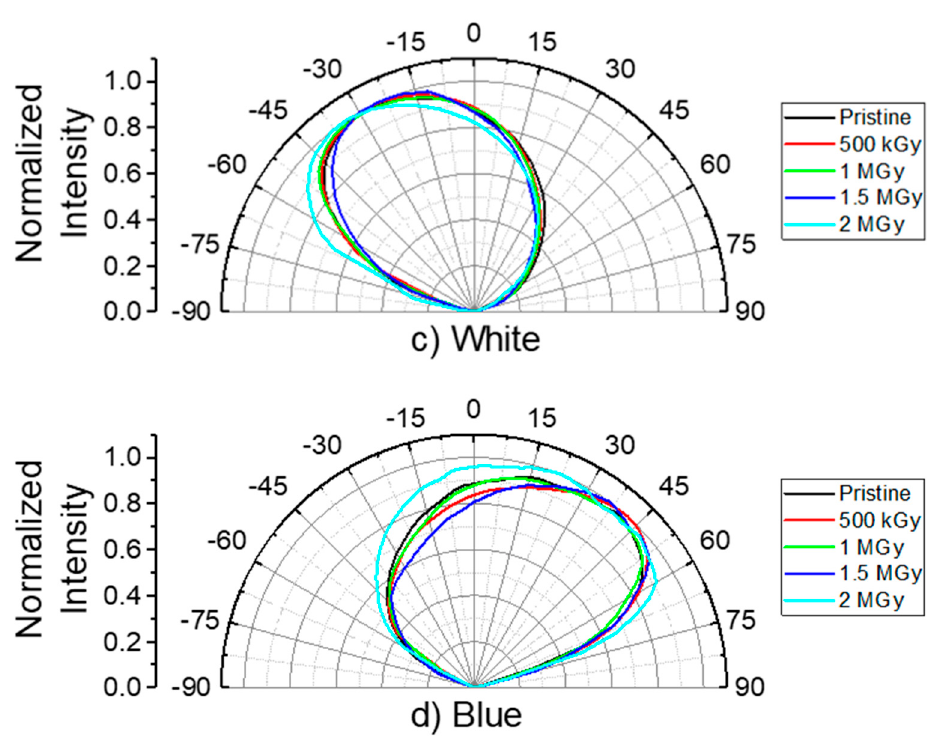
Figure 10. Measured normalized radiation patterns divided by color. The radiation patterns have been averaged between all the samples irradiated at the same dose value.